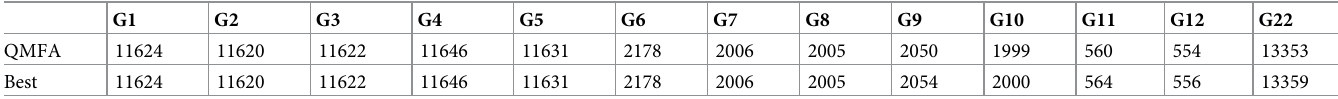
Table 1. G-set benchmarks. QMFA: Our results with the quantum MFA method. Best: Best-known results. G1